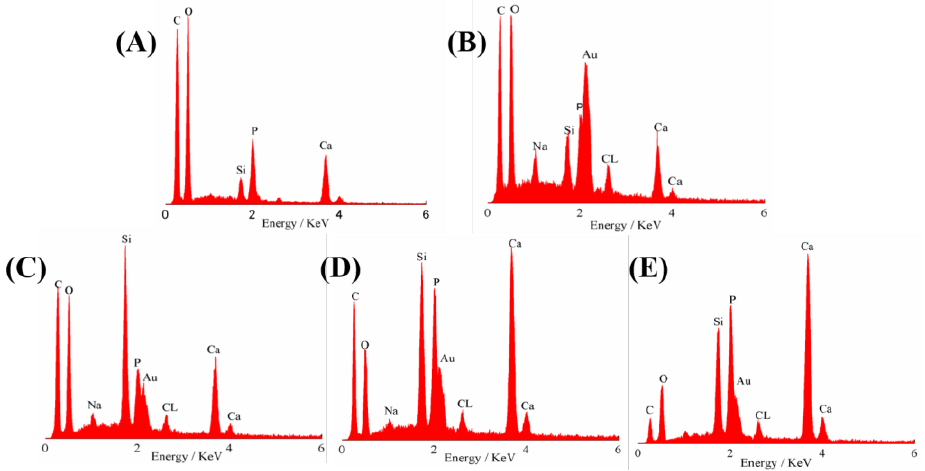
Figure 7. Elemental compositions of the nHA-PBP hybrid membranes with different nHA contents after biomineralization in SBF for 7 days. ( A ) 0 wt% ( B ) 20 wt%; ( C ) 30 wt%; ( D ) 40 wt%; ( E ) 50 wt%.